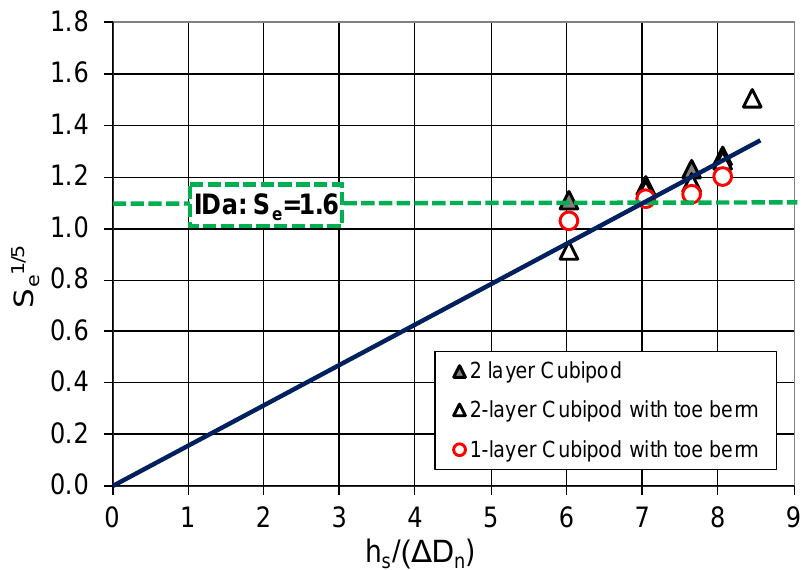
Figure 6. Linearized equivalent dimensionless armor damage Se 1/5 as a function of the dimensionless water depth.